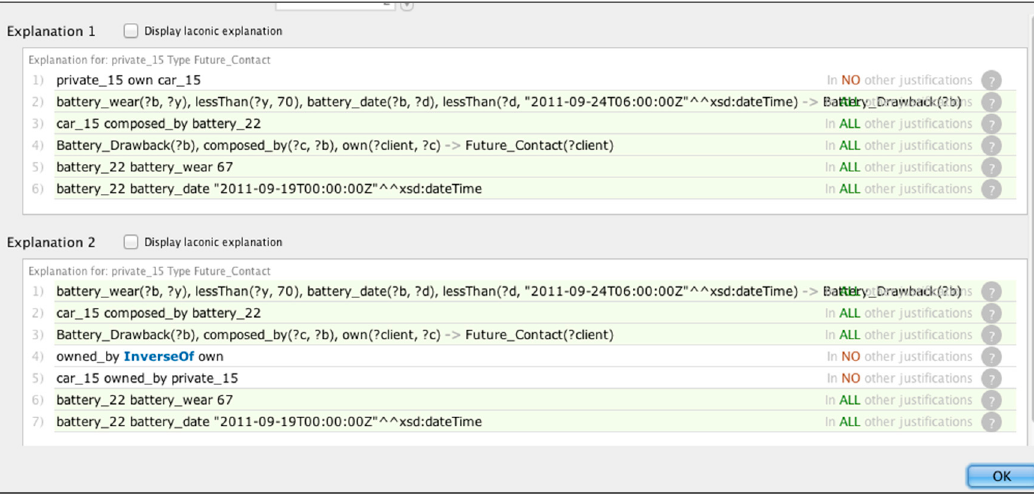
Figure 20. Tracking the reason for the inferred results.